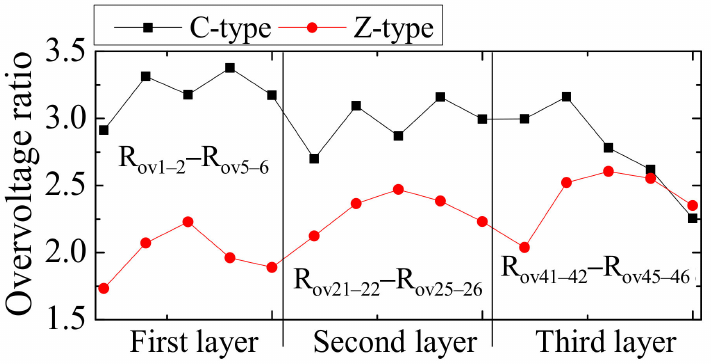
Figure 17. Interturn overvoltage ratio under different winding structures (tr = 200 ns, E r =